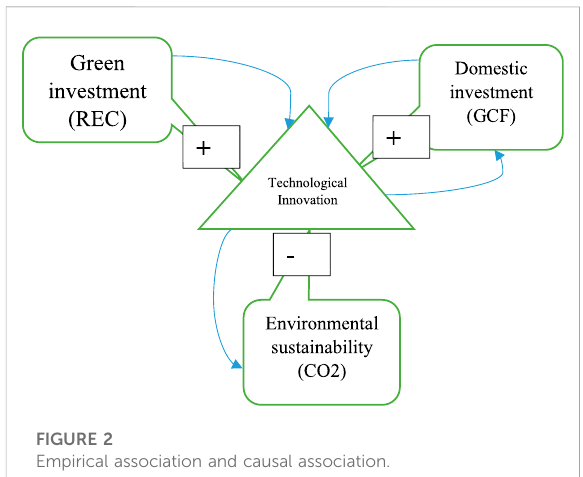
FIGURE 2 Empirical association and causal